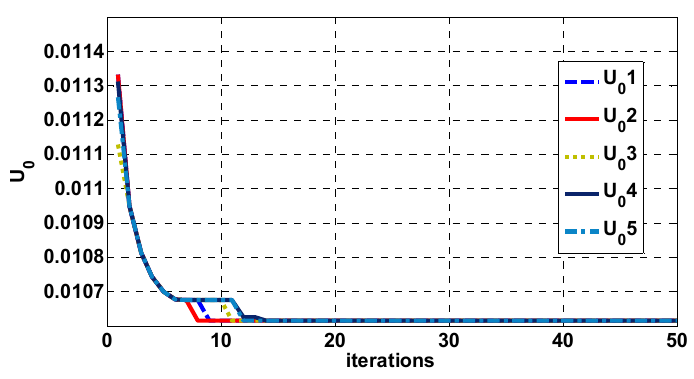
Figure 10. U convergence curves using chaos embedded particle swarm 0 optimization (CEPSO).